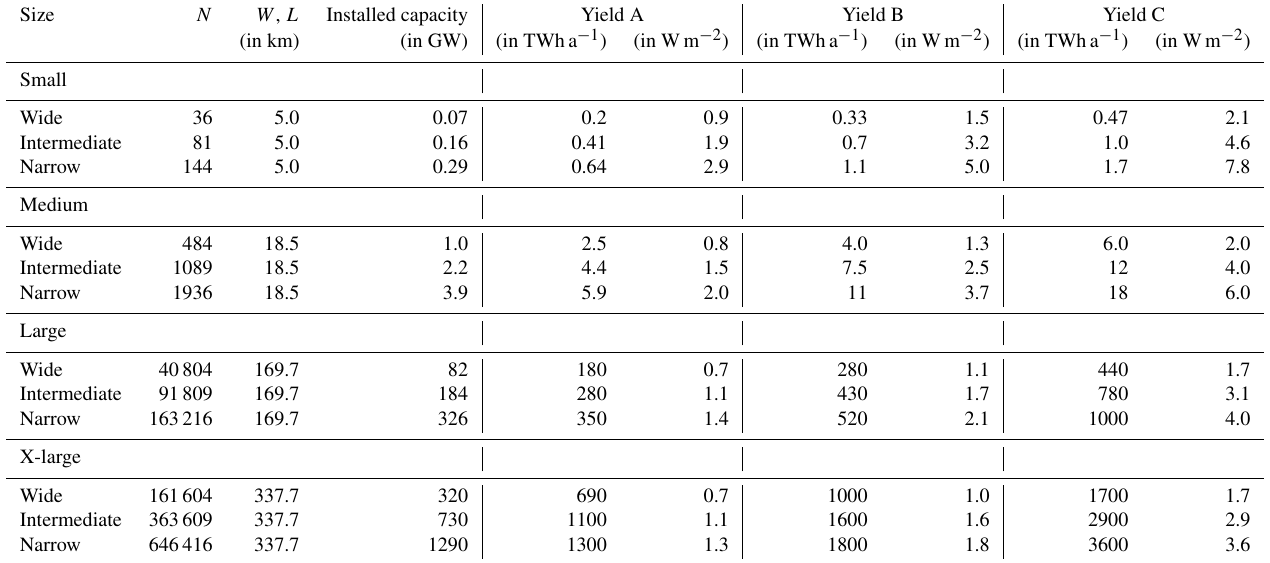
Table 2. Scenarios used to evaluate KEBA, as defined in Volker et al. (2017) for three regions (A, B, and C) and three turbine spacings: wide (10 . 5 D ), intermediate (7 D ), and narrow (5 . 25 D ). The yields are taken from Table 3 of Volker et al. (2017) and are shown in units of TWha − 1 as well as Wm − 2 .